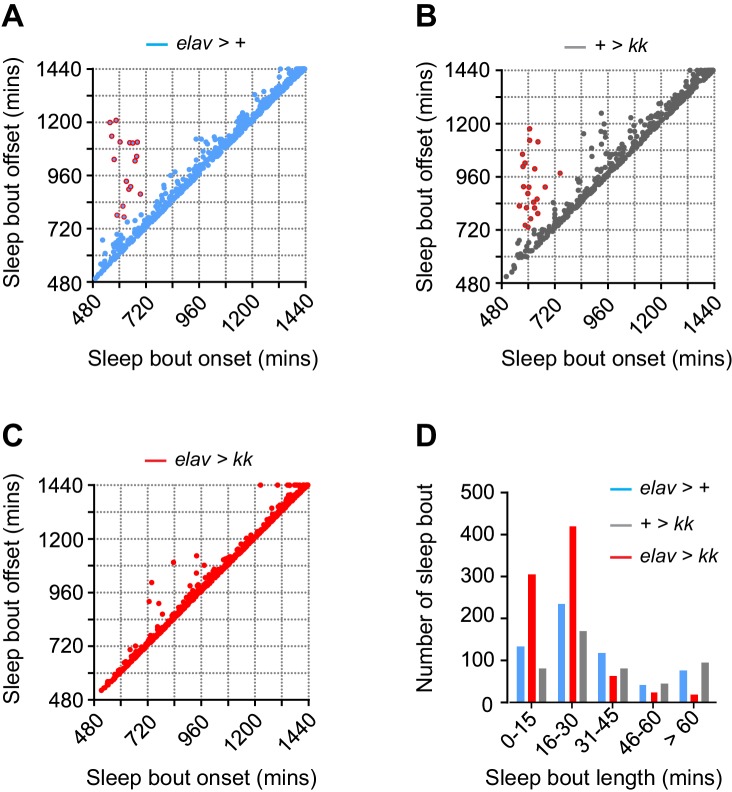
Reduced consolidated sleep in NcaKD flies.(A–C) Individual sleep bout durations were measured using a custom-made R program and visualised by plotting sleep bout onset against offset for sleep bouts in control and NcaKD adult males. In control flies (elav > + and + > kk), longer sleep bouts initiated early during the night are highlighted in red (A, B), which are largely absent in NcaKD adult males (C). n = 48 for each genotype. (D) Distribution of sleep bout lengths in NcaKD and control adult males. Note the significant shift towards shorter sleep bout lengths in NcaKD flies (NcaKD vs. driver alone control, χ2, df: 142.0, 4, p<0.0001; vs. RNAi alone control, χ2, df: 2112.0, 4, p<0.0001).